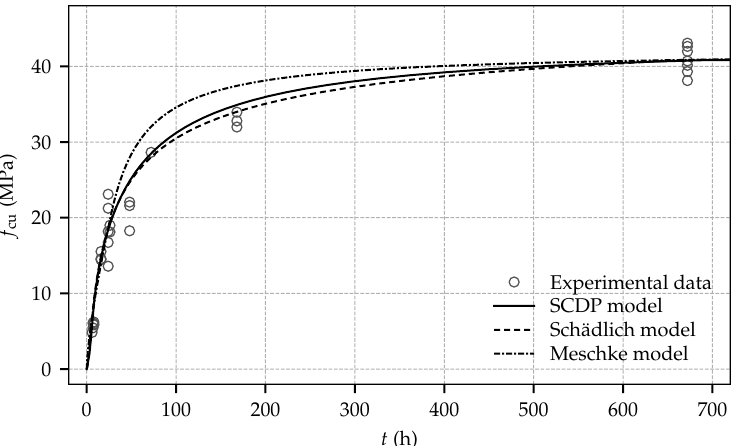
Figure 10. Evolution of the uniaxial compressive strength: experimental results and computed numerical results based on the calibrated shotcrete models.